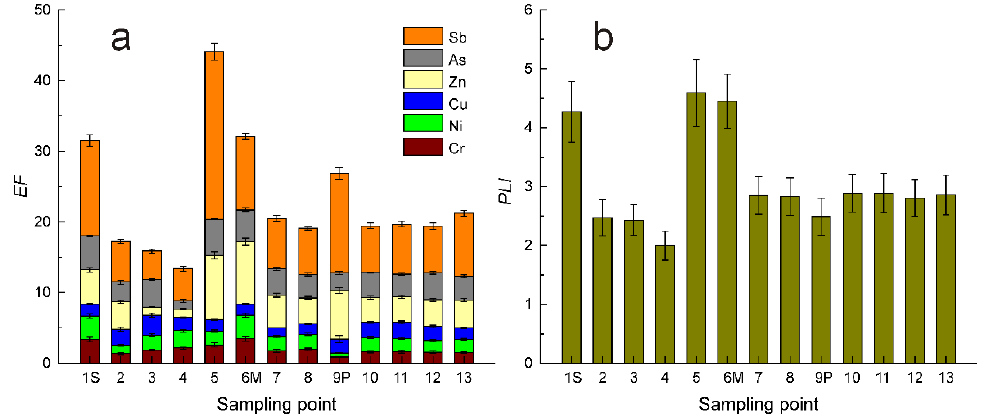
Figure 7. The distribution along the sampling point of individual EF ( a ) [43] and of the more general PLI ( b ) [43].